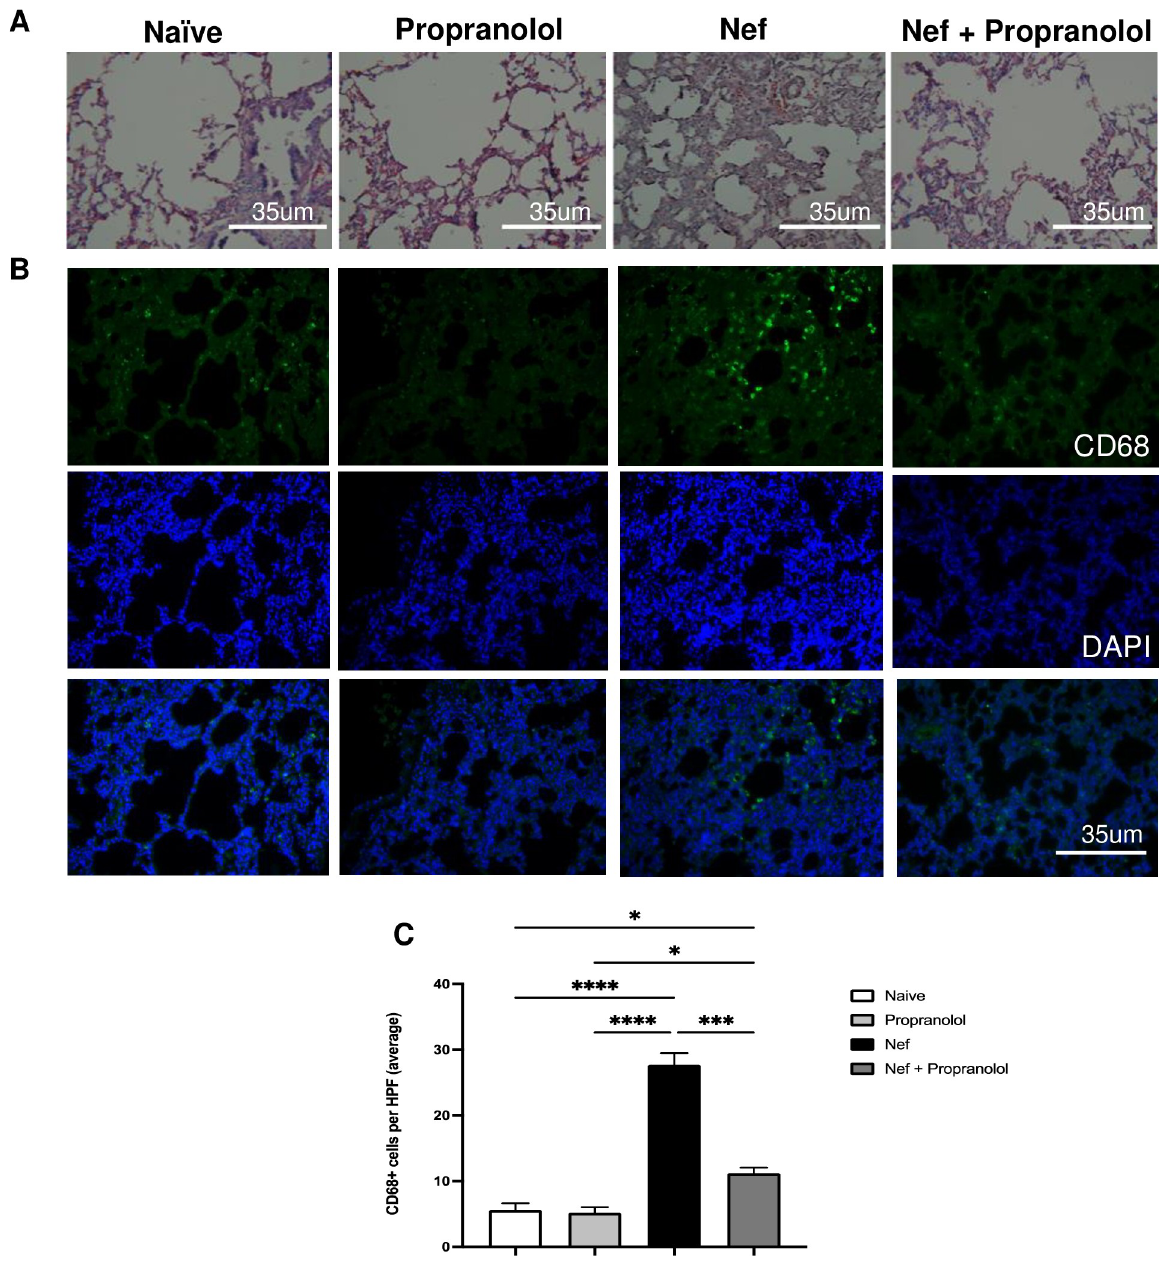
Fig 5. Lung tissue and macrophage infiltration caused by Nef is alleviated through co-administration of propranolol. (A) Hematoxylin & Eosin staining of the lung demonstrated disruption by Nef but healthy tissue in other groups. (B) Representative images of immunofluorescence of CD68+cells (shown in green). (C) Quantification of CD68+ cells confirms that treatment with Nef increases CD68+ cells in the lung, an effect that is neutralized by propranolol treatment. Scale bar indicates 35um. All p-values were two-tailed and statistical significances were defined as � p-value < 0.05, ��� p-value < 0.001, and ���� p-value <